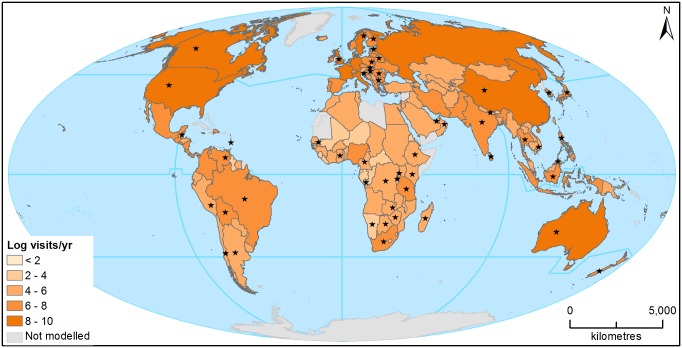
Estimated total PA visit rates for each country.Totals (which are log10-transformed) were derived by applying the relevant regional GLM (S3 Table) to all of a country’s terrestrial PAs (excluding those <10 ha, and marine and IUCN Category I PAs) listed in the WDPA [18]. Asterisks show countries for which we had visit rate observations.